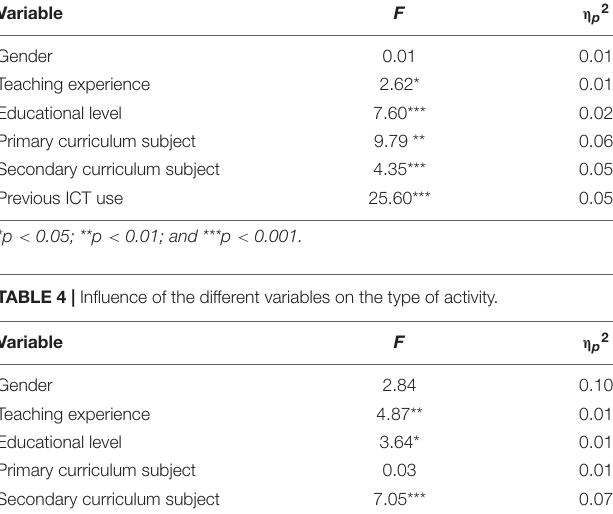
FIGURE 1 | Average of the frequencies of each type of